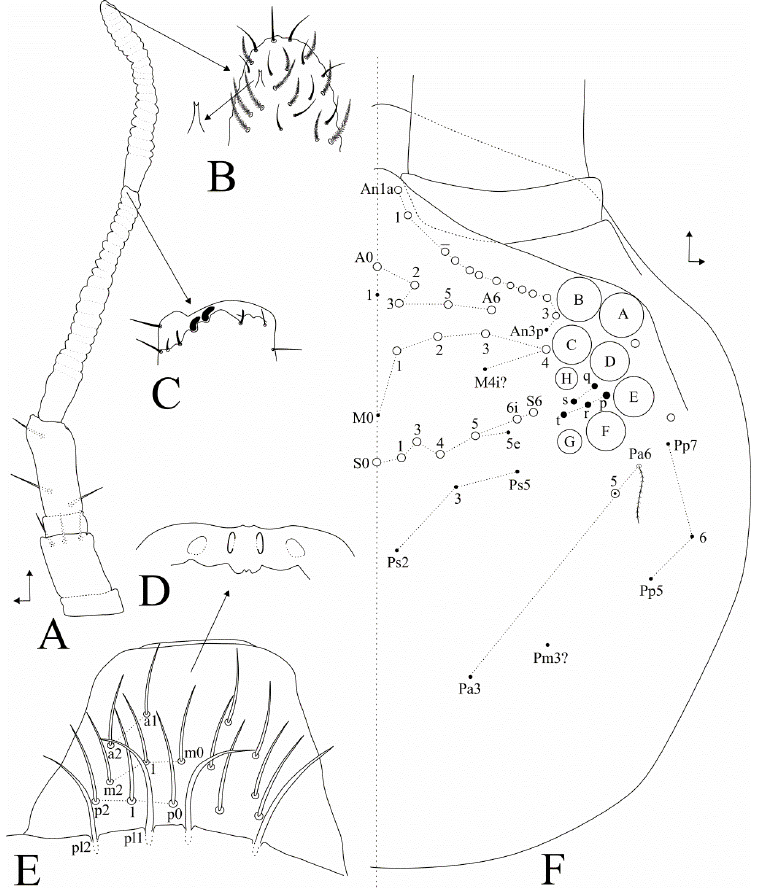
Figure 2. Dicranocentrus abestado sp. nov. head: ( A ) left antenna (dorsal view); ( B ) apical Ant. IV (ventro-lateral view), arrow indicates bifurcate pin projection; ( C ) apical organ of Ant. III (ventro- lateral view); ( D ) labral papillae; ( E ) labral and pre-labral chaetotaxy; ( F ) dorsal head chaetotaxy and eyes (right side).